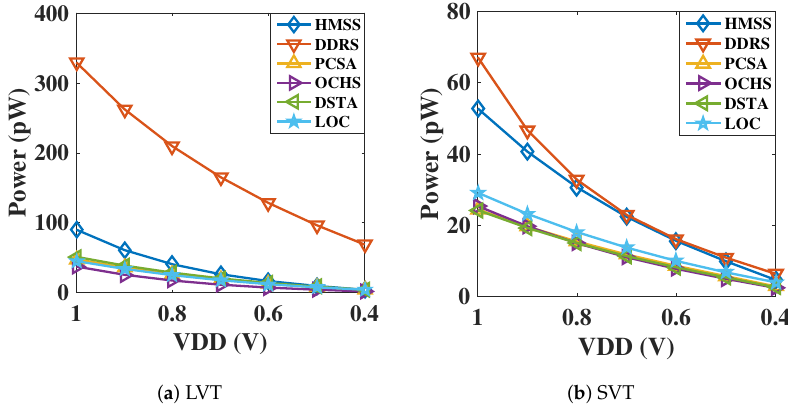
Figure 7. Static power consumption versus V dd scaling down in sensing circuits with ( a ) low VT transistor and ( b ) regular VT